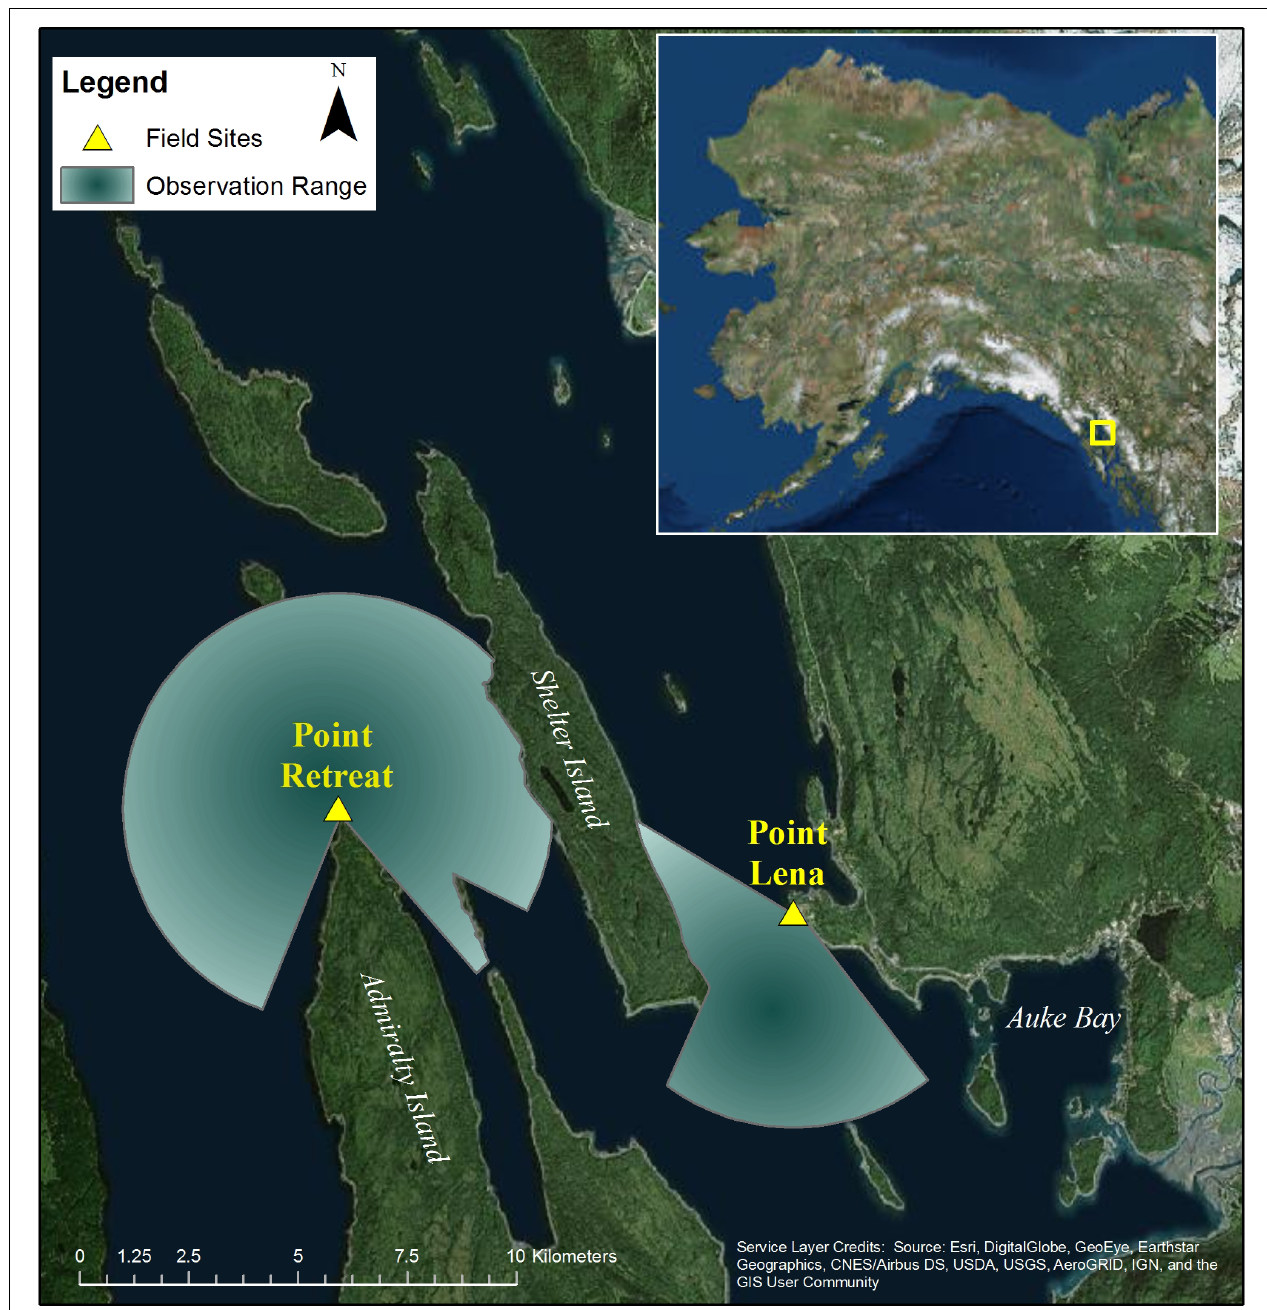
FIGURE 1 | Map of Juneau whale watch tour area with field sites and corresponding observation ranges up to 5 km. Field sites were located at Point Lena (58.39140 N, 134.77495 W), at the NOAA Ted Steven’s Marine Research Institute, and Point Retreat (58.41308 N, 134.95644 W), at the lighthouse on the northern point of Admiralty Island. Most whale watching vessels depart from Auke Bay, with both sites located within the typical tour area. Each site was positioned at a high vantage point necessary for observing and tracking whales using a theodolite accurately up to 5 km (station height of 37.2 m, and 21.9 m, respectively).